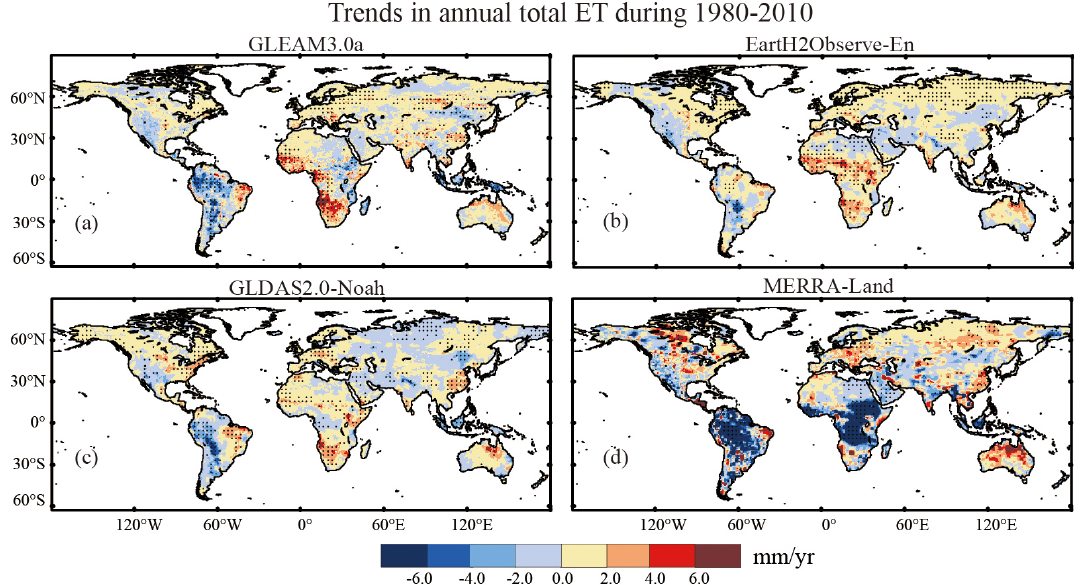
Figure 2. The spatial distribution of pixel-wise linear trends of annual ET for (a) GLEAM3.0a, (b) EartH2Observe-En, (c) GLDAS2.0-Noah, and (d) MERRA-Land products during 1980–2010. The trend is estimated with Theil–Sen’s slope method, and the significance level is tested with the Mann–Kendall method. The dotted area indicates that the trend has passed the significance test at 5% level. Table 2. The percentage of grids in each dominant factor controlling annual ET linear trends for GLEAM3.0a, EartH2Observe-En, GLDAS2.0-Noah, and MERRA-Land. The “ + ” and “ − ” represent positive, and negative contributions to ET, respectively. P R n T 1 VPD u GLEAM3.0a + 30.34% 4.03% 0.79% 27.32% 0.06% − 25.07% EartH2Observe-En +